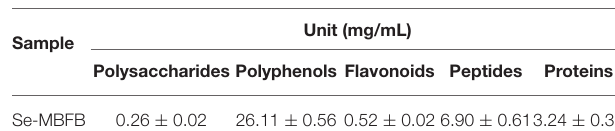
TABLE 1 | Chemical composition of Se-MBFB.